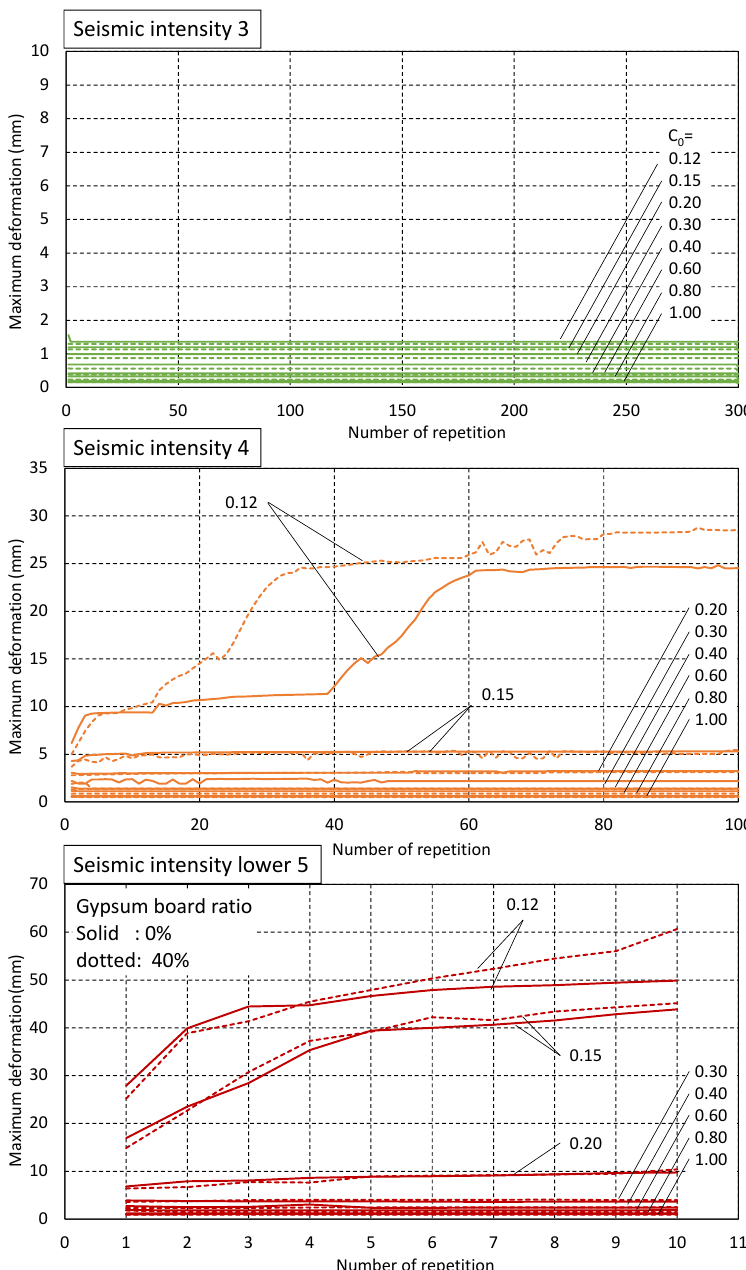
Figure 15. Deformation due to numerous moderate earthquakes.